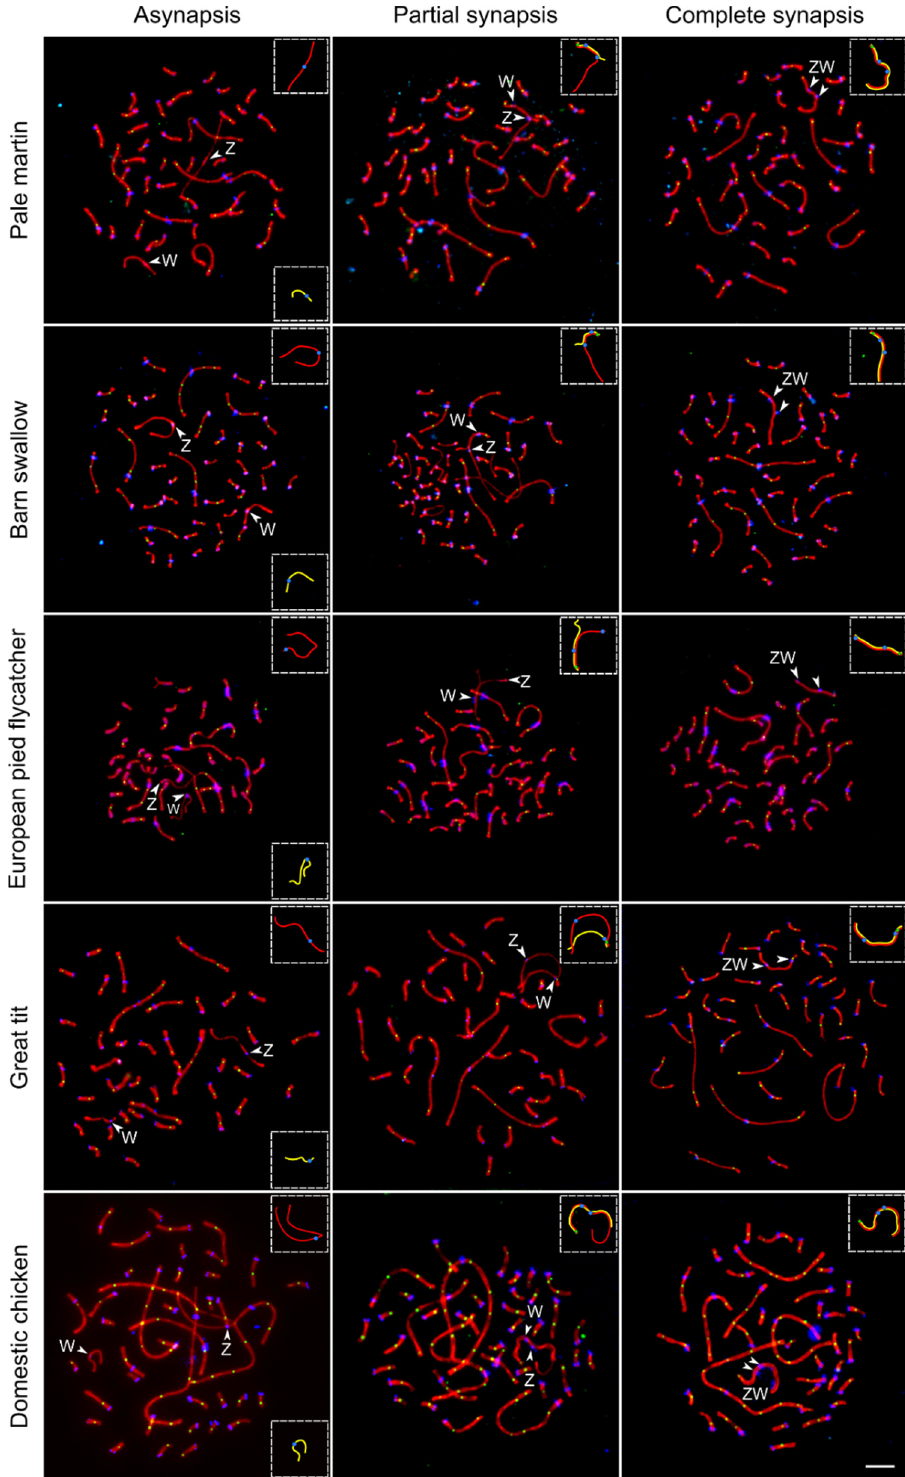
Figure 1. Synaptic configurations of the ZW SCs during pachytene in five bird species visualized by anti-SYCP3 (red), anti-MLH1 (green) and anticentromere (blue) antibodies. Arrowheads indicate centromeres of Z and W chromosomes. Inserts show schematic representations of Z (red) and W (yellow) SCs. Bar—5 μ m. After synapsis was established, it expanded to the differentiated parts of the sex chro- mosomes. The expansion was accompanied by synaptic adjustment and axis equalization (shortening of Z-axis and elongation of W-axis). It was completed by a formation of